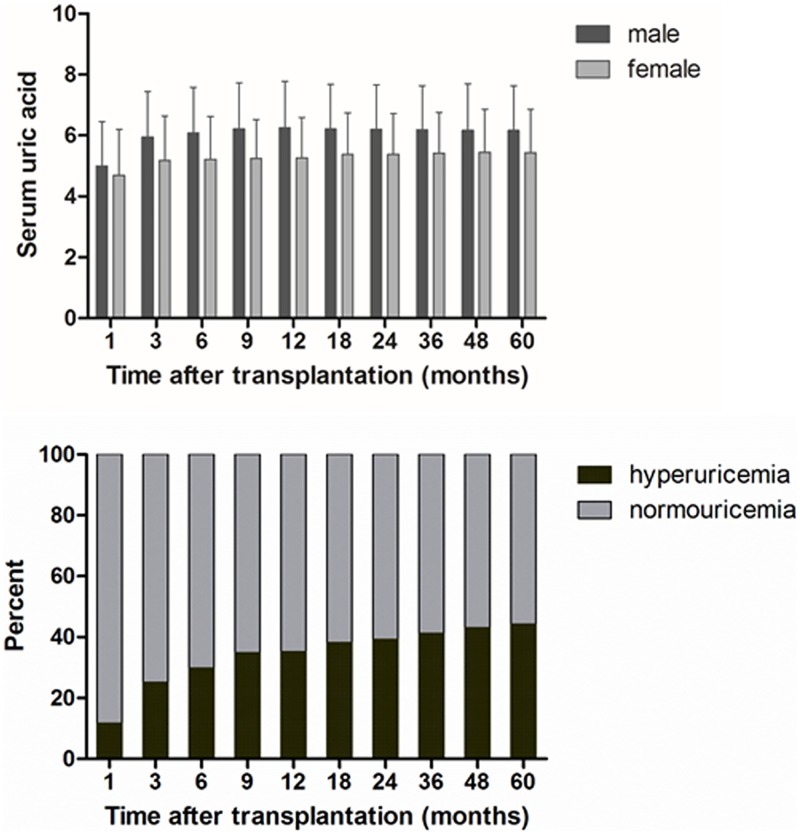
(A) Trends in serum uric acid levels and (B) the proportion of patients with hyperuricemia.Serum uric acid level rose steadily and the proportion of hyperuricemia increased over time after transplantation.